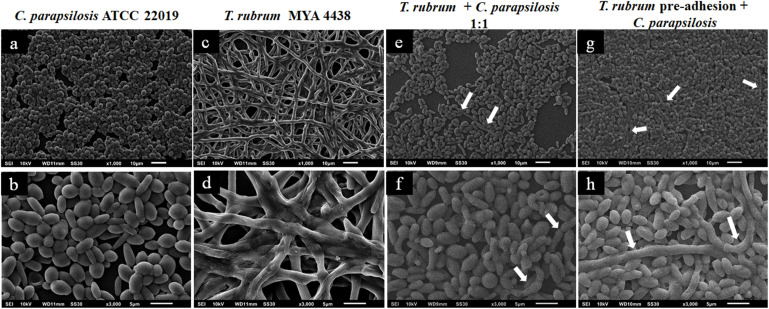
Scanning electron microscopies of monospecies biofilms of C. parapsilosis ATCC 22019 (a,b) and T. rubrum ATCC MYA 4438 (c,d) and dual-species biofilms of C. parapsilosis/T. rubrum formed at a proportion of 1:1 (e,f) or formed with the addition of C. parapsilosis suspensions after the pre-adhesion of T. rubrum biofilm (g,h). White arrows denote the hyphae of T. rubrum.